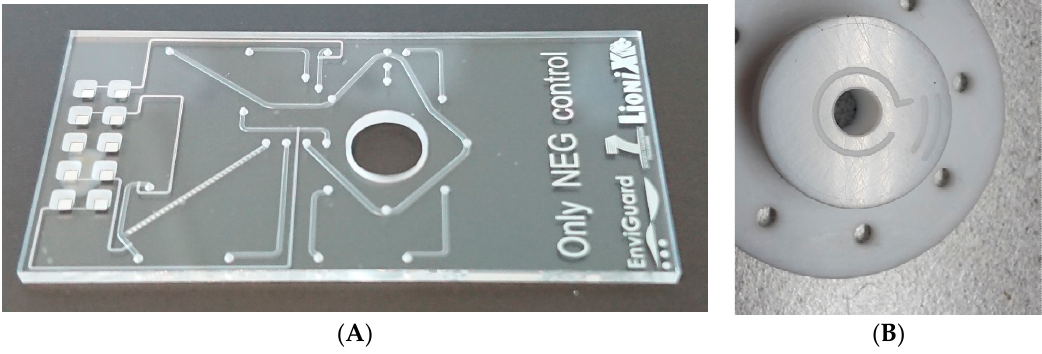
Figure A1. Design of the fluidic valve-chip ( A ) and the rotor ( B ). ( A ) Etched channels are in blue; connections towards the rotor are orange dots; connections towards the system are in light blue. The green circle is the cutout through which the rotor’s axe will pass. The mixing structure is indicated